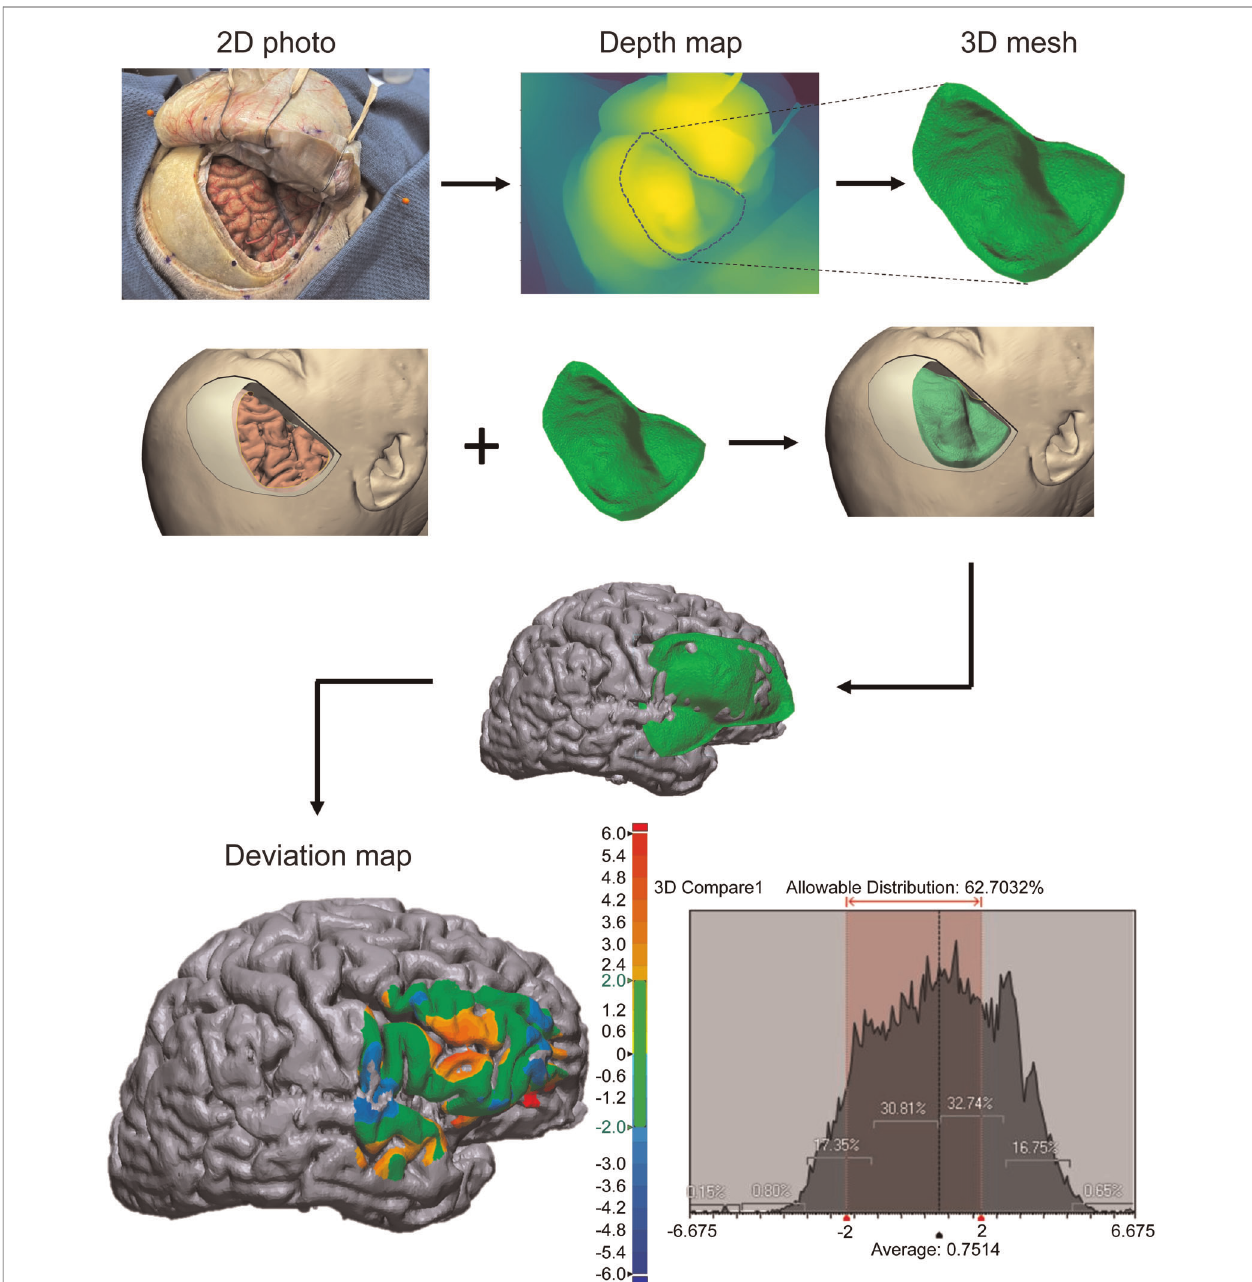
FIGURE 4 | Validation of monocular-depth estimation technique using the 3D virtual model. A single operative photograph was used to create a depth map and corresponding 3D mesh. This mesh was then imported into the 3D virtual model space as an object. Two models (3D mesh of the photographic depth map and 3D virtual model) were aligned, and the deviation map between 2 surfaces was created. The deviation map shows that almost two-thirds of the entire surface area matches almost perfectly between the 2 models (within 2-mm limits). The epicenter and edges show the highest degrees of distortion. Colored scale bar indicates the degree of distortion in millimeters. Used with permission from Barrow Neurological Institute, Phoenix, Arizona